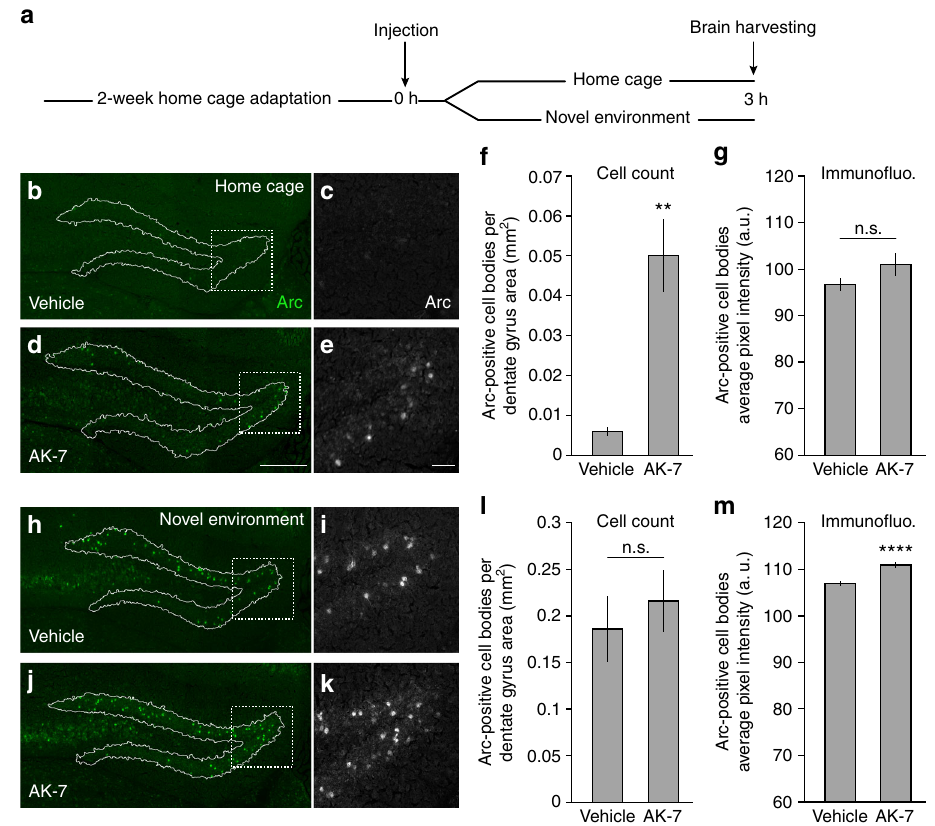
Fig. 9 KDAC inhibitor AK-7 in fl uences Arc protein level in vivo. a Experimental design used to assess the in fl uence of AK-7 on Arc protein expression in mice dentate gyrus exposed to a familiar (home cage) or novel environment. b – e Representative captures of Arc immunostaining in the dentate gyrus of mice 3 h after intraperitoneal injection of vehicle ( b , c ) or AK-7 ( d , e , 30 mg kg − 1 ). Scale bar 250 µ m. Mice were returned to their home cage immediately after the injection and left undisturbed for the time period before killing. High-magni fi cation image of the area highlighted by a dotted square in b , d are presented in c , e , respectively. Scale bar 50 µ m. f , g Quanti fi cation of number of immunopositive Arc cells per mm 2 for the whole dentate gyrus of mice injected with vehicle or AK-7 and returned to their home cage ( f ) and average Arc immuno fl uorescence signal intensity in cell bodies ( g ). Data represent average made from three mice for each experimental condition. ** p < 0.01, two-tailed t -test. h – k Representative captures of Arc immunostaining in the dentate gyrus of mice treated as in b – e but that were placed in a novel environment for 3 h immediately after the vehicle ( h , i ) or AK-7 ( j , k ) injection. Strong Arc expression caused by novel environment exposure can be observed in both conditions. l , m Quanti fi cation of number of Arc immunopositive cells per mm 2 in dentate gyrus reveals that no difference between the two injection groups for mice exposed to a novel environment ( p = 0.571, two-tailed t -test) but quanti fi cation of Arc immuno fl uorescence in cell bodies was signi fi cant. **** p < 0.0001, two-tailed t -test. Data represent average made from three mice for each experimental condition. Dentate gyrus boundaries in each tissue section (with line) was segmented according to DAPI